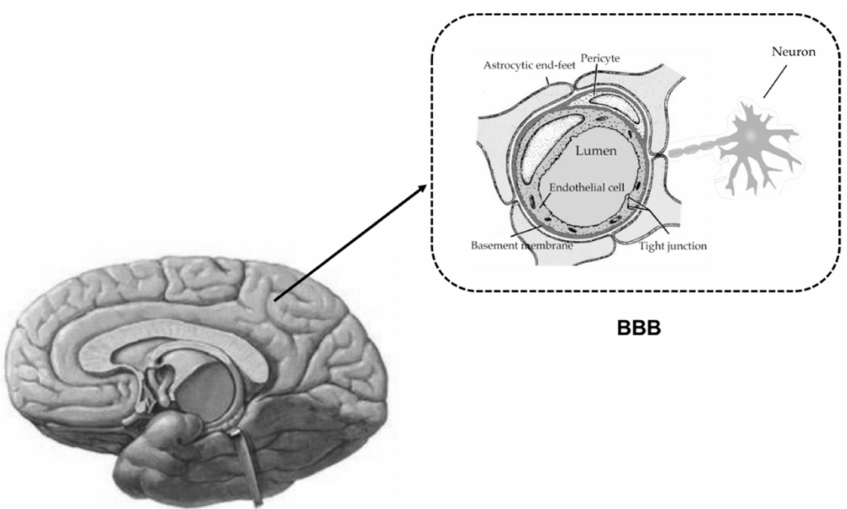
Figure 1. Cellular interfaces between blood and brain parenchyma (blood-brain barrier, BBB). The endothelial cells and the closely apposed pericytes are completely unsheathed by overlapping astrocytic end-feet and neuronal terminals, forming “neurovascular unit”